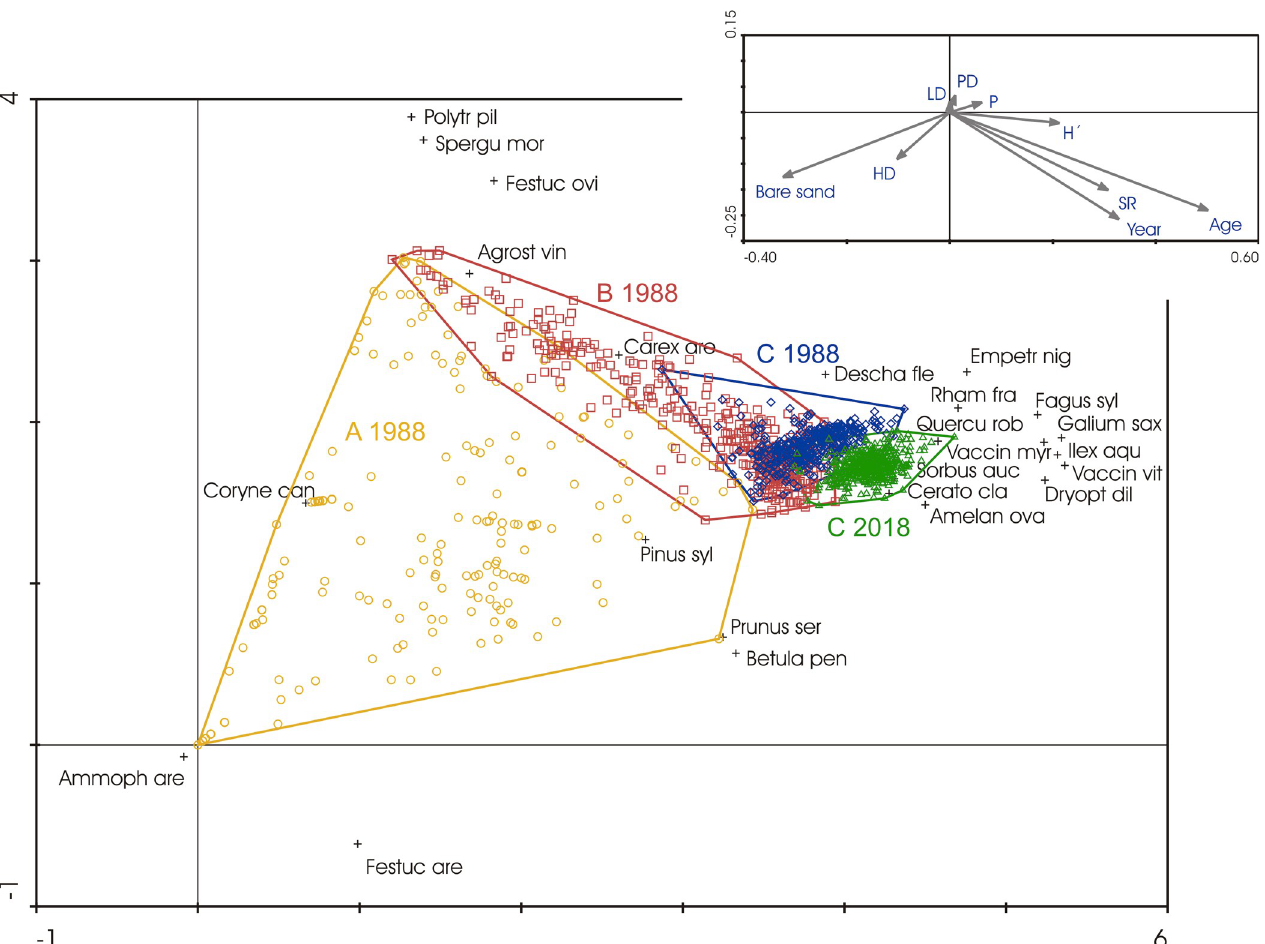
Fig 1. Biplot of DCA with samples classified (and outlined by envelopes) according to plot assignment (A, B or C) and year of sampling, and species with the highest weight (layers of woody species were combined into a single one). Percentage cover values were transformed with a logarithmic function. Eigenvalues of the first two axes were 0.727 and 0.211; total inertia 4.789. Vectors of supplementary variables are shown in the upper right corner: P–Plain; LD–Low dunes; HD–High dunes; PD–Plateau dunes; SR–Species richness; H’–Species diversity of vascular plants; Age–successional age; Year–year of